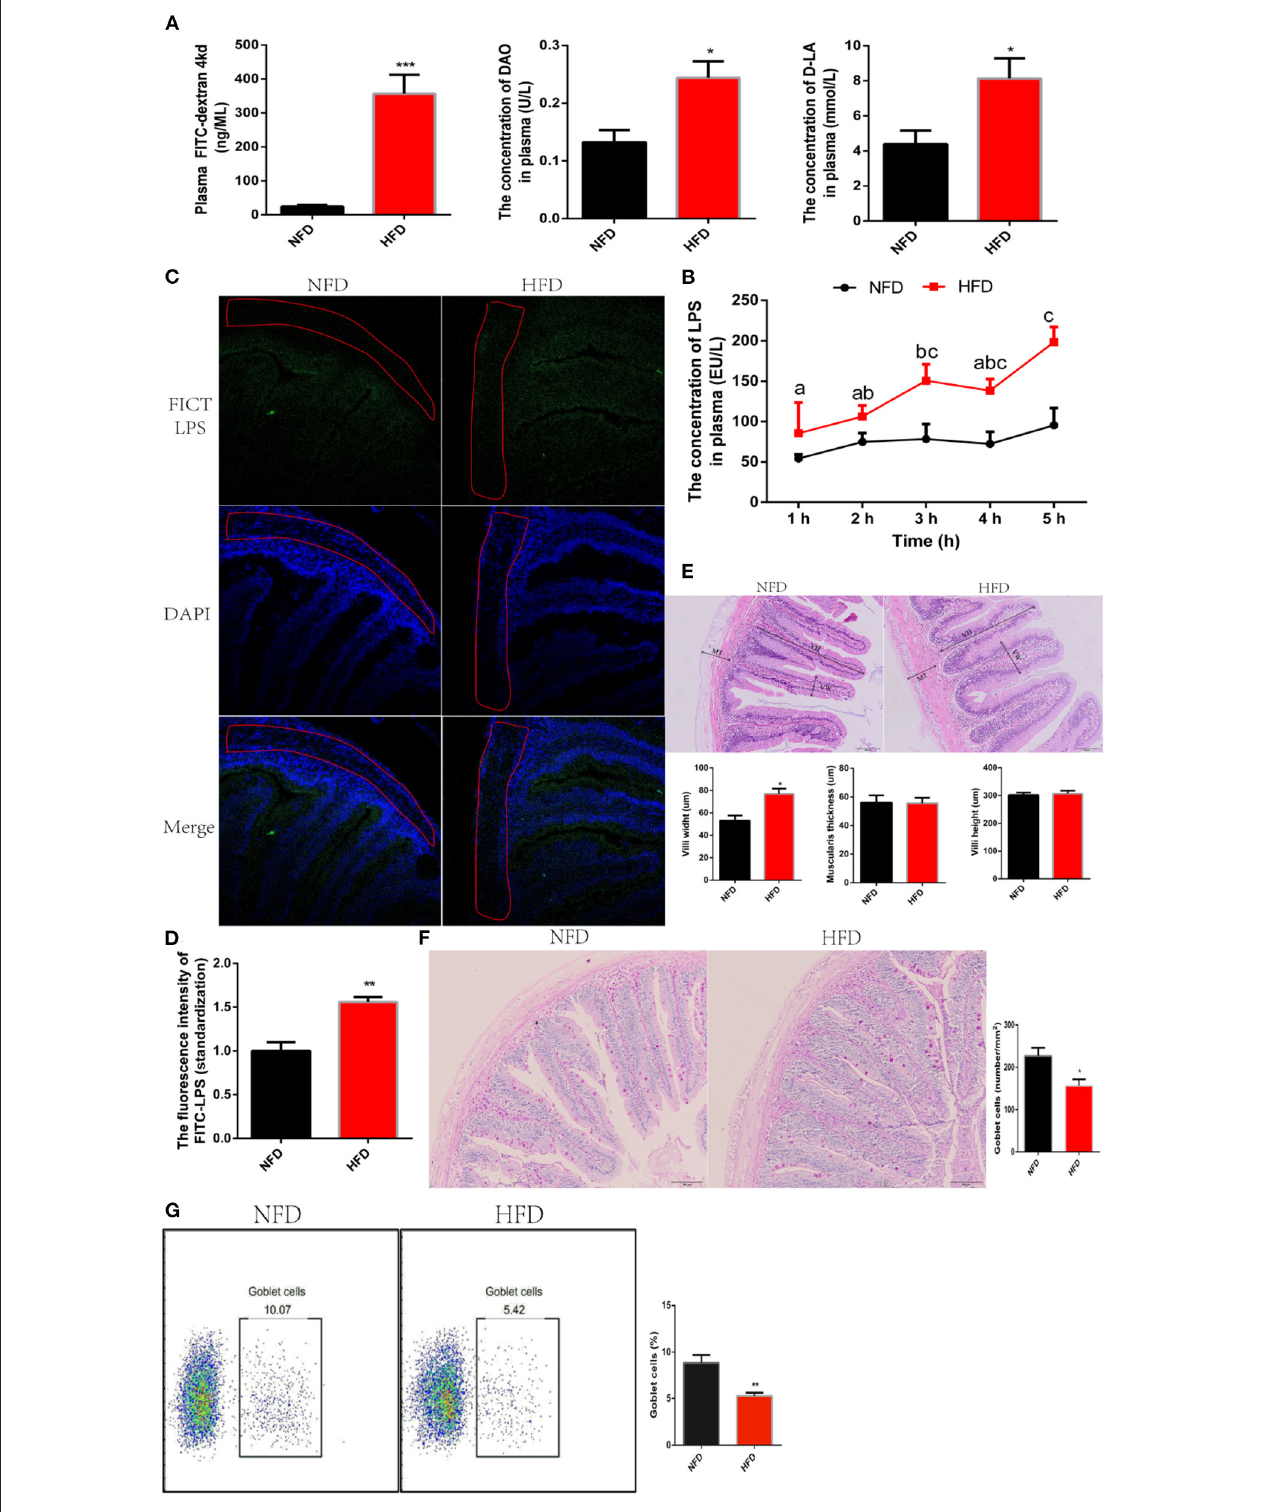
FIGURE 3 | High-fat diets increase intestinal permeability and then weaken the interception of LPS. (A) Parameters of intestinal permeability: pasma FITC-d, D-LA and DAO. Plasma FITC-d was measured at 4 hours after oral administration of (900 mg/kg) FITC-d. (B) Assessment of LPS penetration into the circulation.